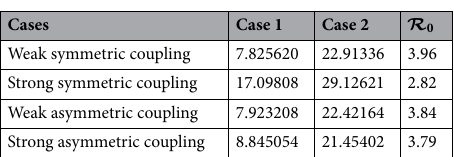
Table 3. The total number of infections averted over a 100 day period.